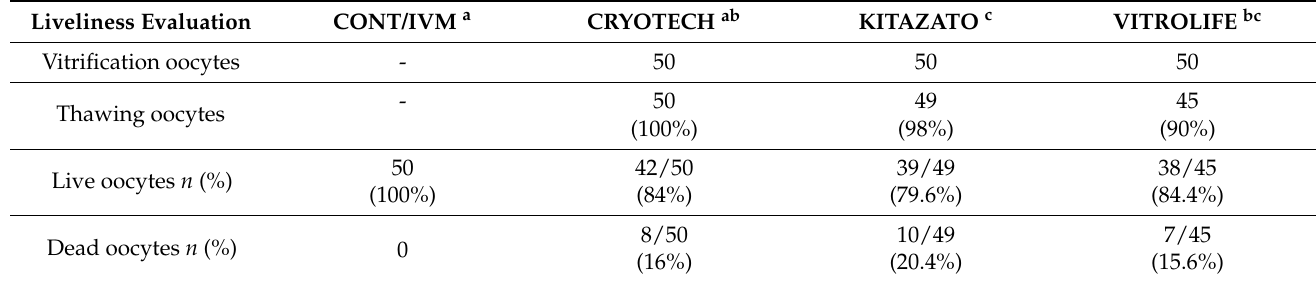
Table 2. Results of vitrification of IVM oocytes with different commercial protocols.